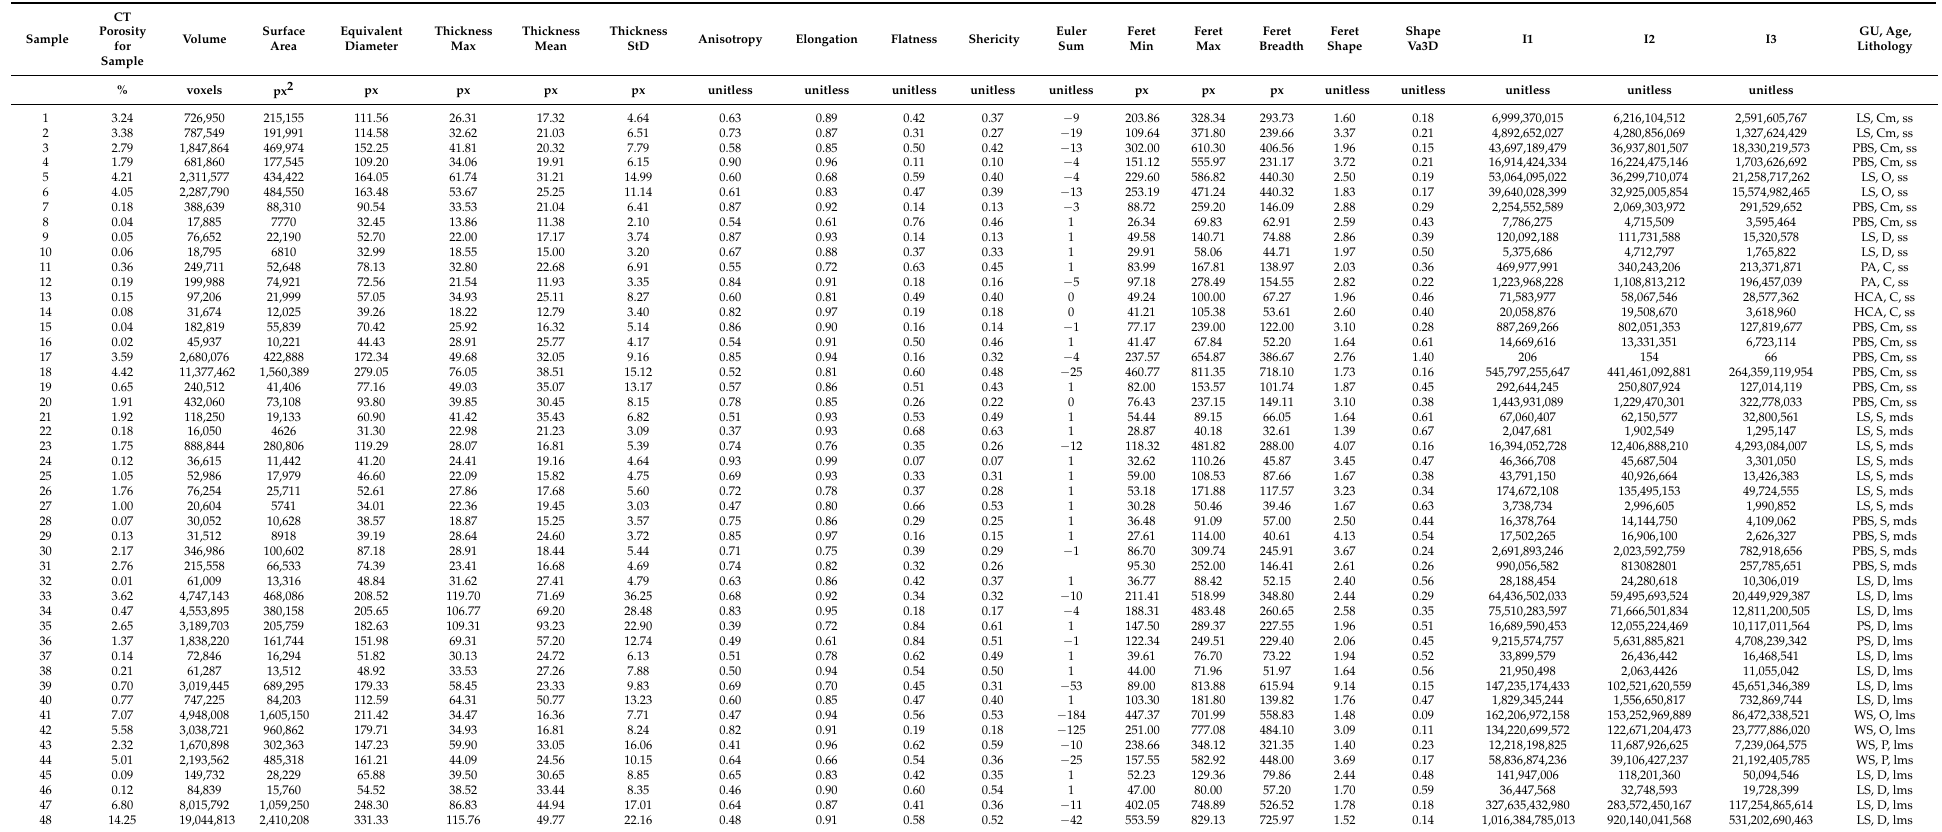
Table A1. Basic geometrical parameters of the largest object in the analyzed samples (part of one data set consisted of parameters for the largest object in the samples). Symbols of geometrical parameters are explained in the text. Symbols: GU—geological unit in Poland, LU—Lublin Synclinorium, PBS—Peri-Baltic Syneclise, PA—Pomeranian Anticlinorium,